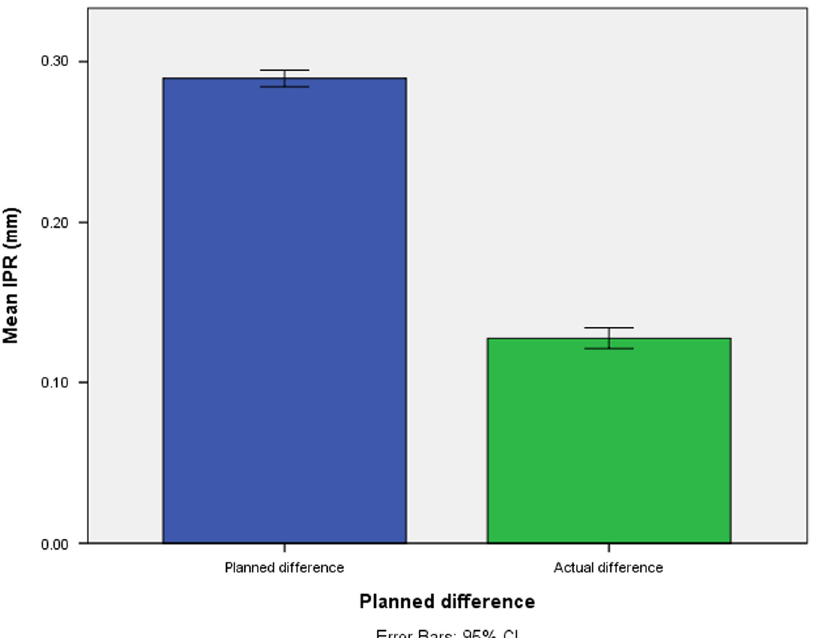
Figure 4. Summary chart showing mean planned and achieved tooth width changes for all teeth ( n = 2,474) from all 10 orthodontists